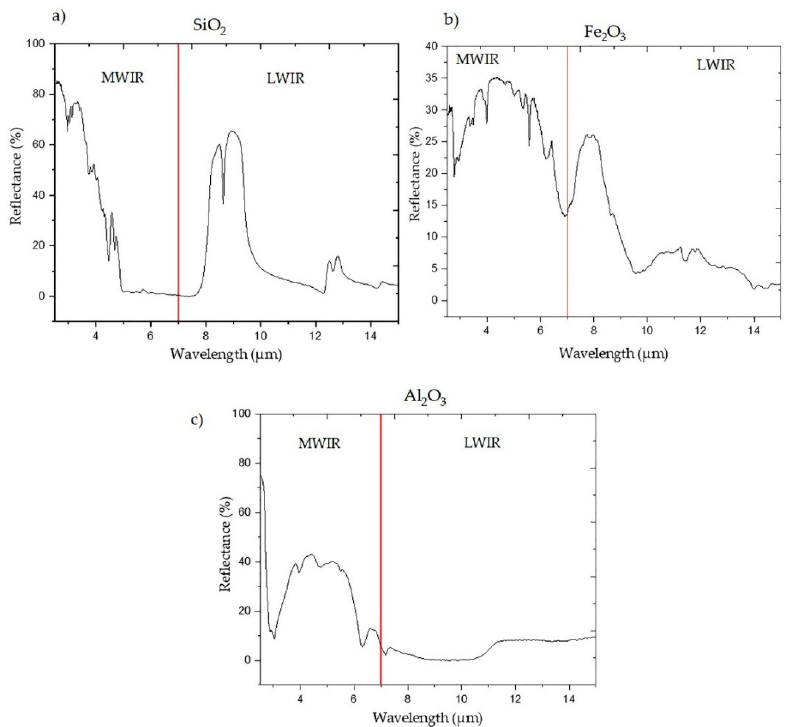
Figure 3. The mid-wave infrared (MWIR) and long-wave infrared (LWIR) reflectance spectra of ( a ) SiO 2 ; ( b ) Fe 2 O 3 ; and ( c ) Al 2 O 3 (Source: Ecostress Spectral library [50]).